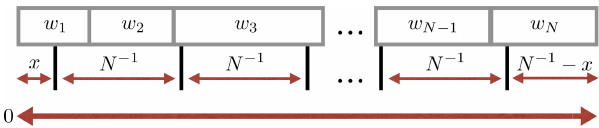
Figure 1. Illustration of the universal resampling process. A ran- dom number x is drawn from a uniform distribution in the interval [ 0 , N − 1 ] . The endpoint of this number indicates the first particle. Then N − 1 is added (N − 1 ) times to this random number, where every endpoint is a particle of the new ensemble. In the illustration, particle one is chosen once, particle two is not chosen once and particle three is chosen twice. This way some particles are repli- cated and other particles are dropped. If the model does not have a stochastic model error, it is necessary to perturb the new particles; otherwise they would be identical and the filter would